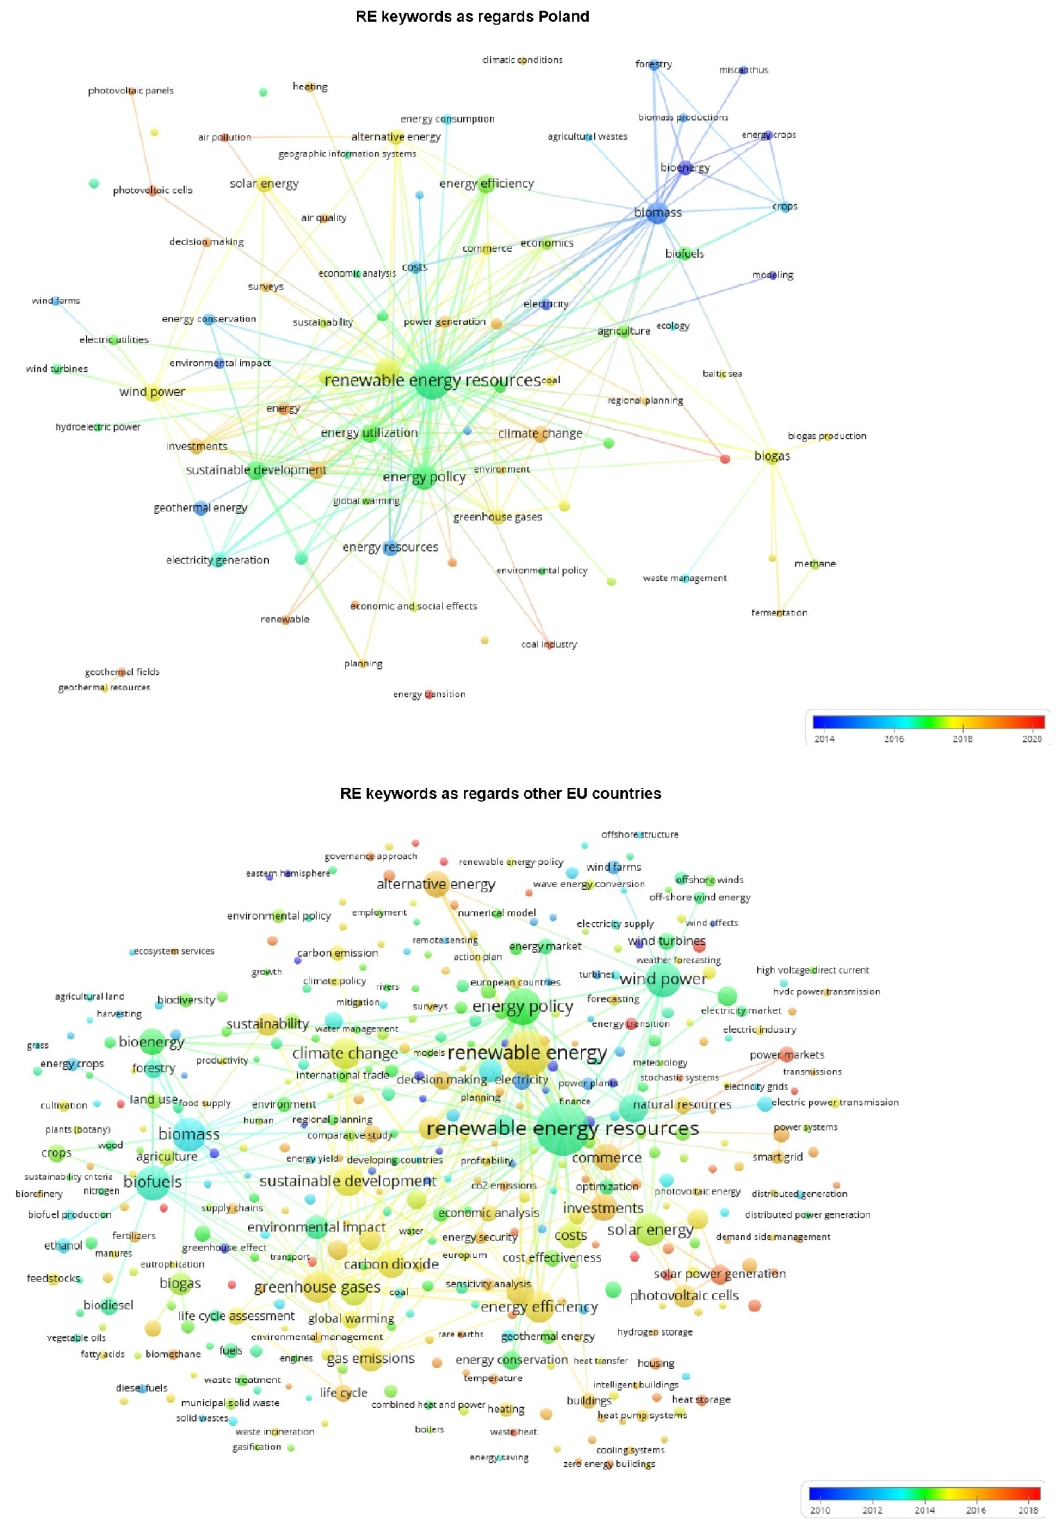
Figure 4. Keywords and keywords co-occurrence mapping for publications on RE research in a temporal aspect.